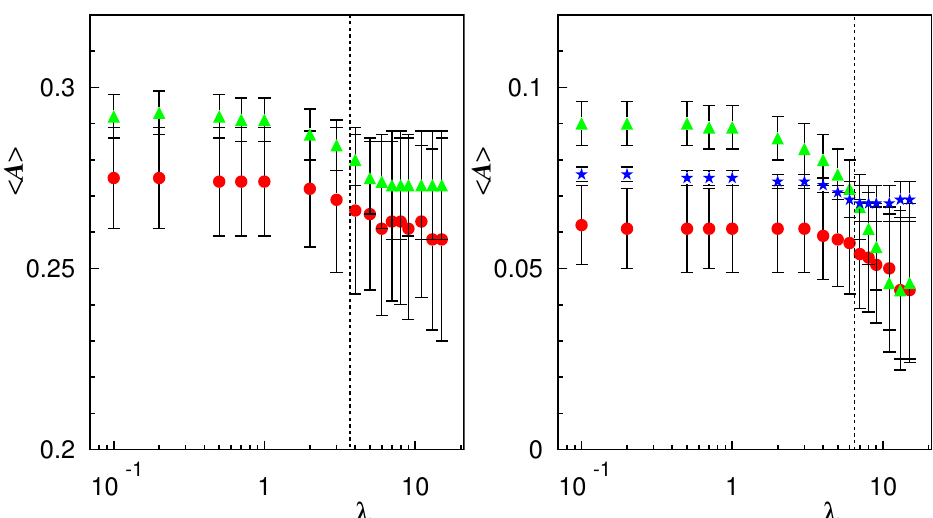
Figure 6. Average values of the asphericity (cid:104) A (cid:105) as a function of λ at S ∗ = 0.80 ( left ) and S ∗ = 0.95 ( right ) for κ / ( k B TR 0 ) = 6.58 ( • ), 65.8 ( (cid:78) ), 164.5 ( (cid:63) ). The tank-treading to tumbling transition in the Keller–Skalak theory [5] is marked by the dashed vertical lines. Error bars are given by the root-mean-square fluctuation values of the asphericity.